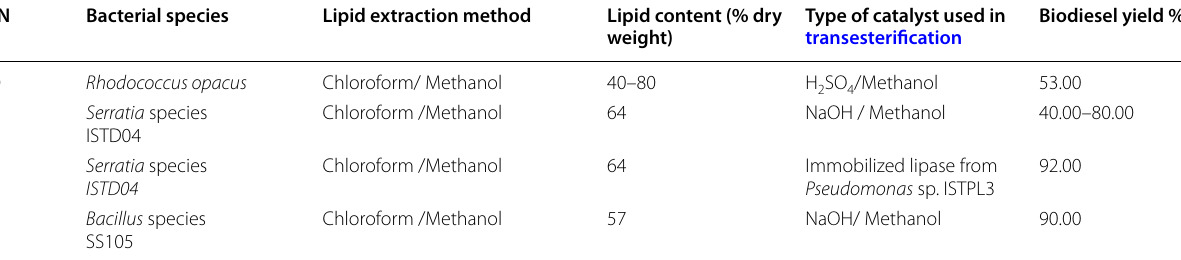
Table 4 Extraction method, lipid content and biodiesel yield (Bharti et al. 2014a; Goswami et al. 2017; Kumar et al. 2017a, b; Maheshwari et al.